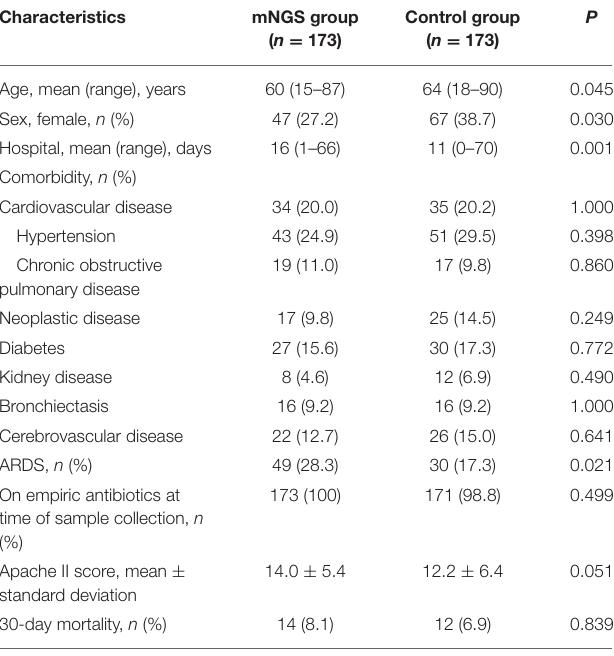
TABLE 1 | Demographic and baseline characteristics of patients. Characteristics